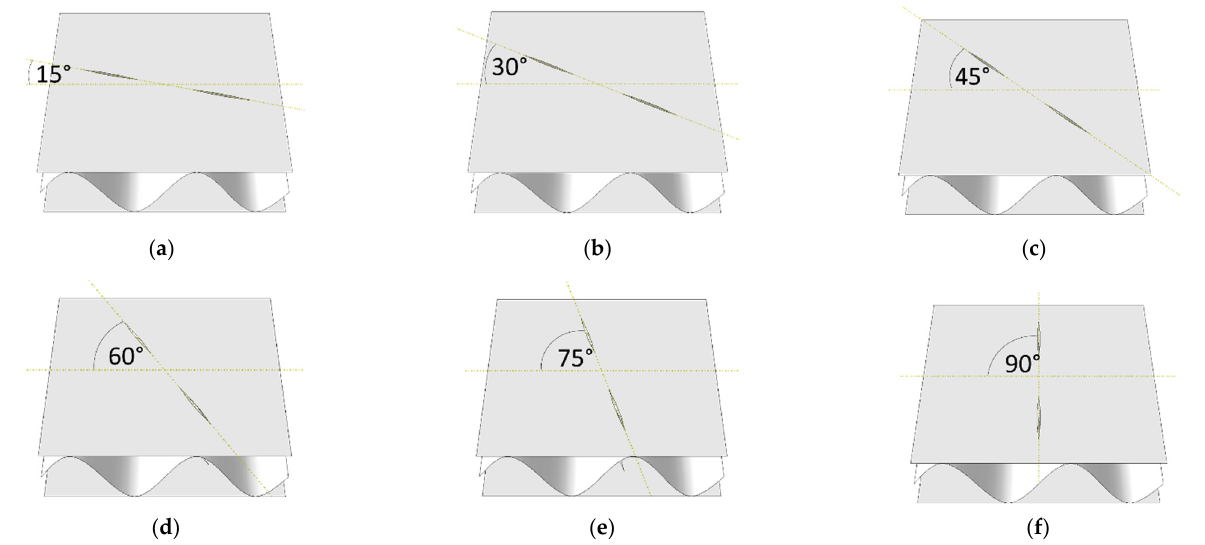
Figure 5. Perforation orientation in sample SW-44-C: ( a ) rotation by 15 degrees; ( b ) rotation by 30 degrees; ( c ) rotation by 45 degrees; ( d ) rotation by 60 degrees; ( e ) rotation by 75 degrees; ( f ) rotation by 90 degrees.